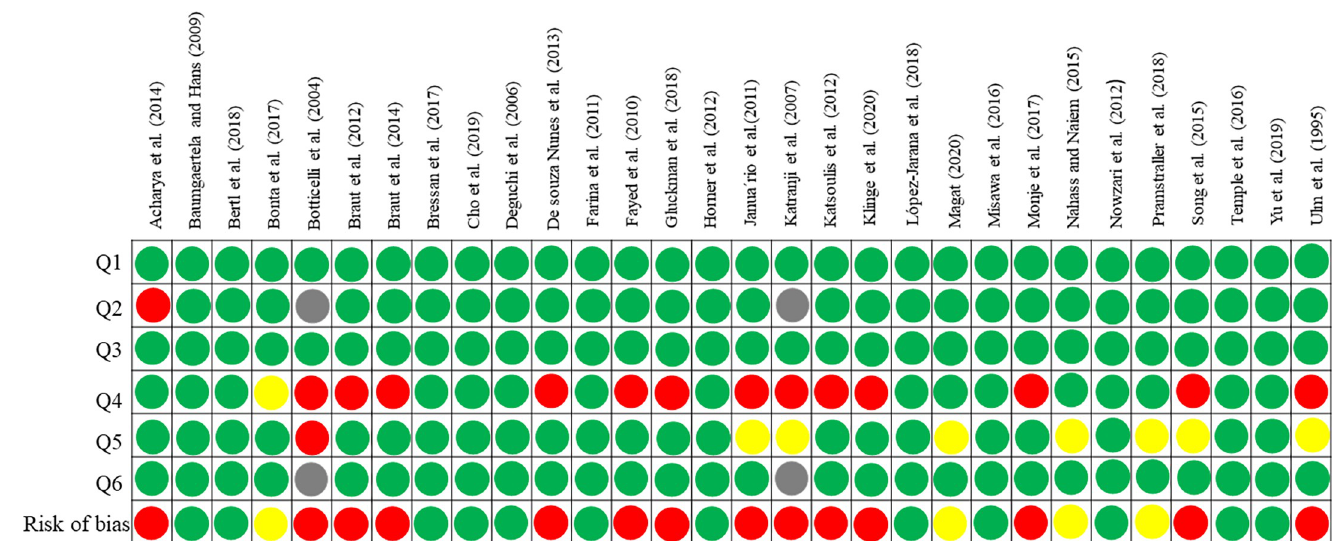
Fig 3. Risk of bias assessment for the included studies. Green indicates low risk, yellow-medium and red-high risk. Grey means undefined.